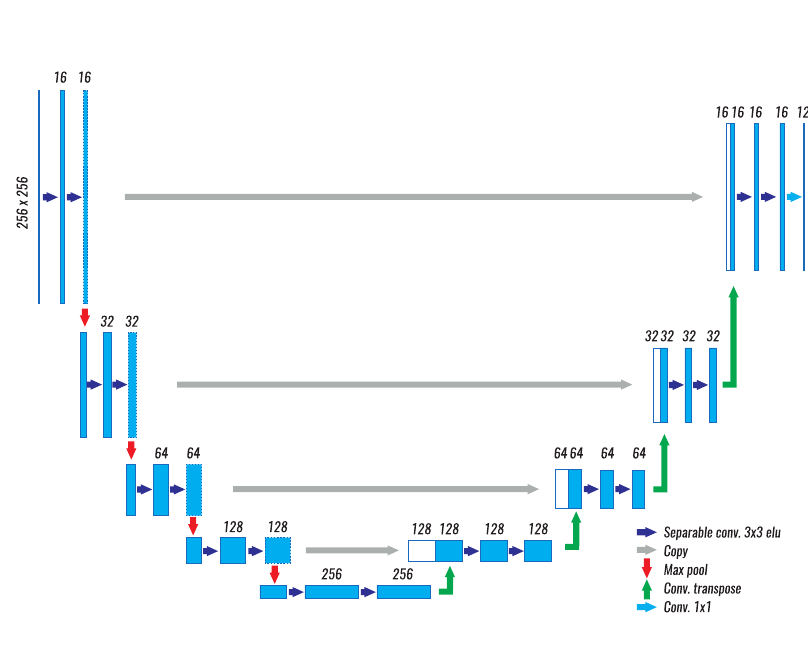
Figure 5. Graphic description the architecture selected.